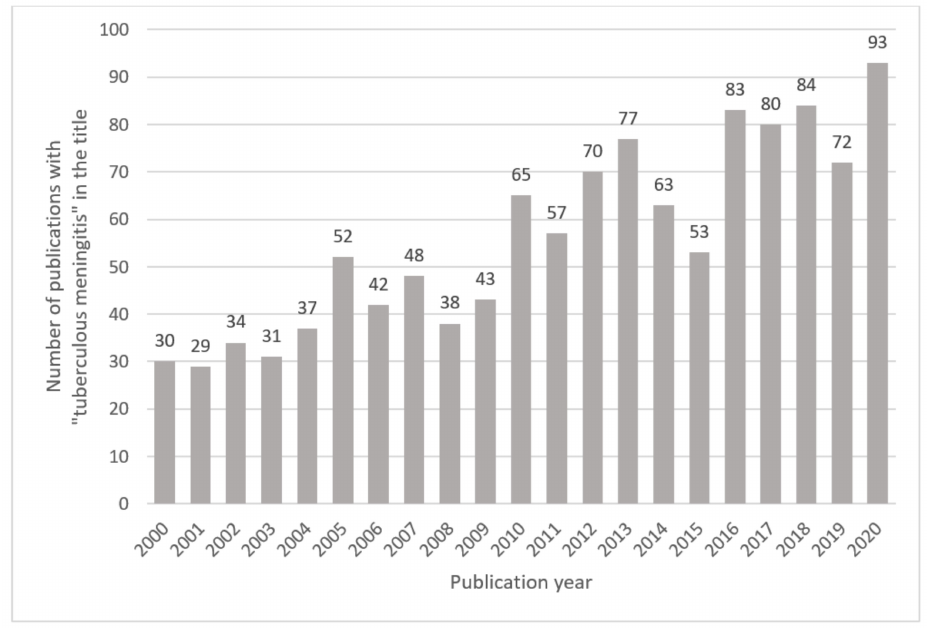
Figure 2. Number of publications with “tuberculous meningitis” in the title published between 2000 and 2020. Results are based on an online PubMed